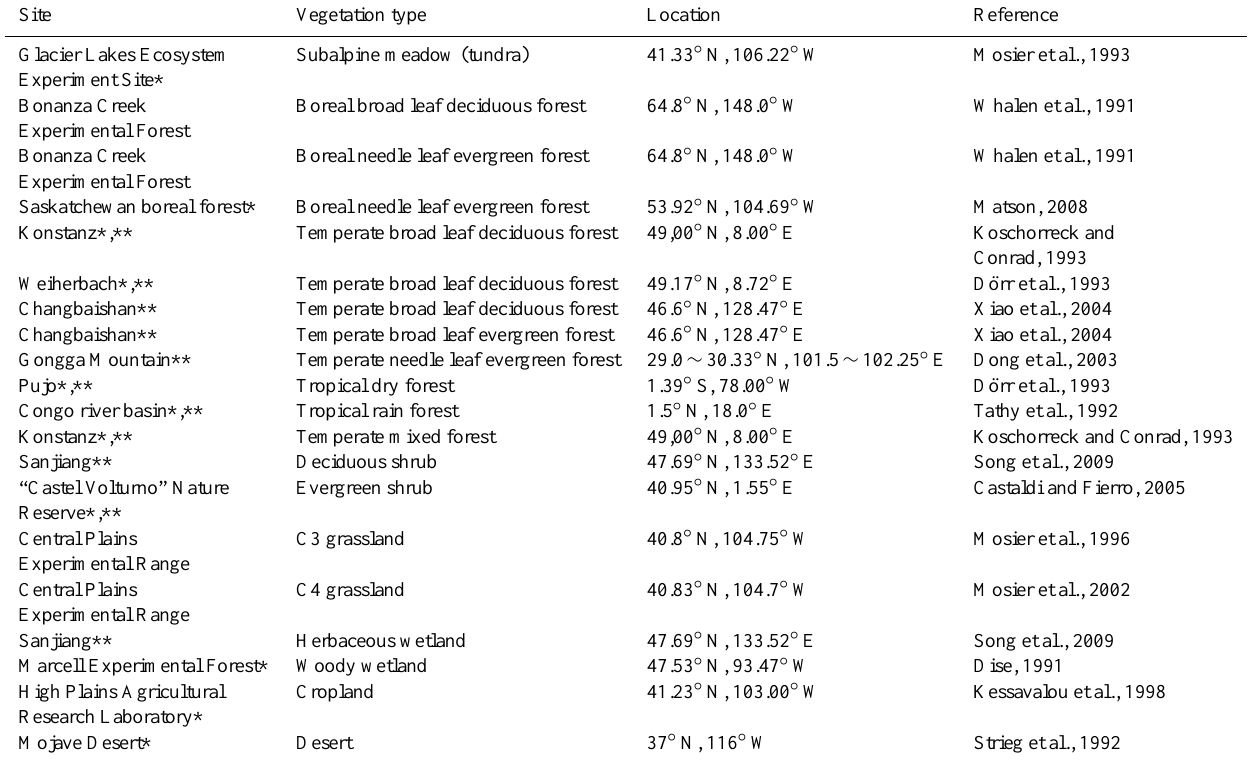
* Indicates portions of model-driven forces from regional dataset; ** indicates site outside of the continental North America.